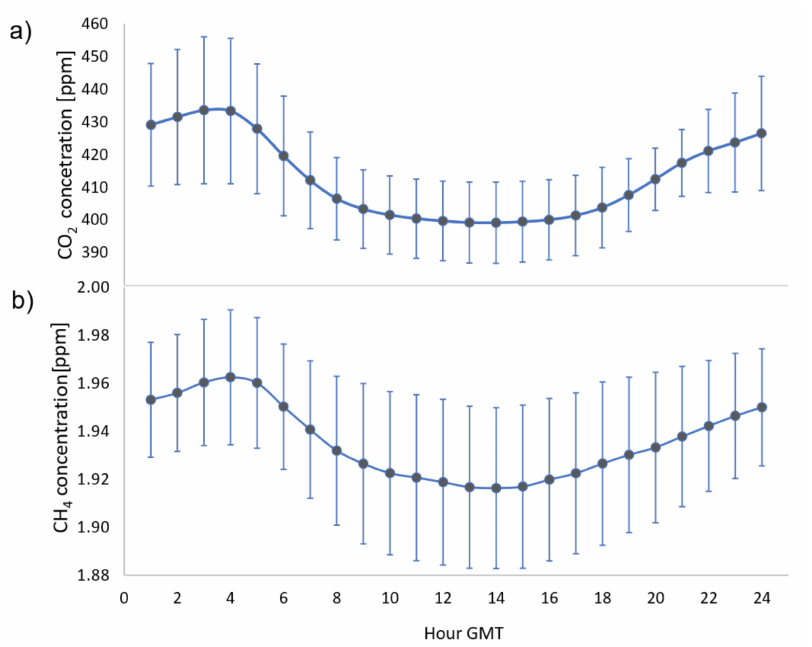
Figure 3. Diurnal variation (mean value together with 1 standard deviation) of CO 2 ( a ) and CH 4 ( b ) at the Stary Wiec station, August 2015–July 2017.